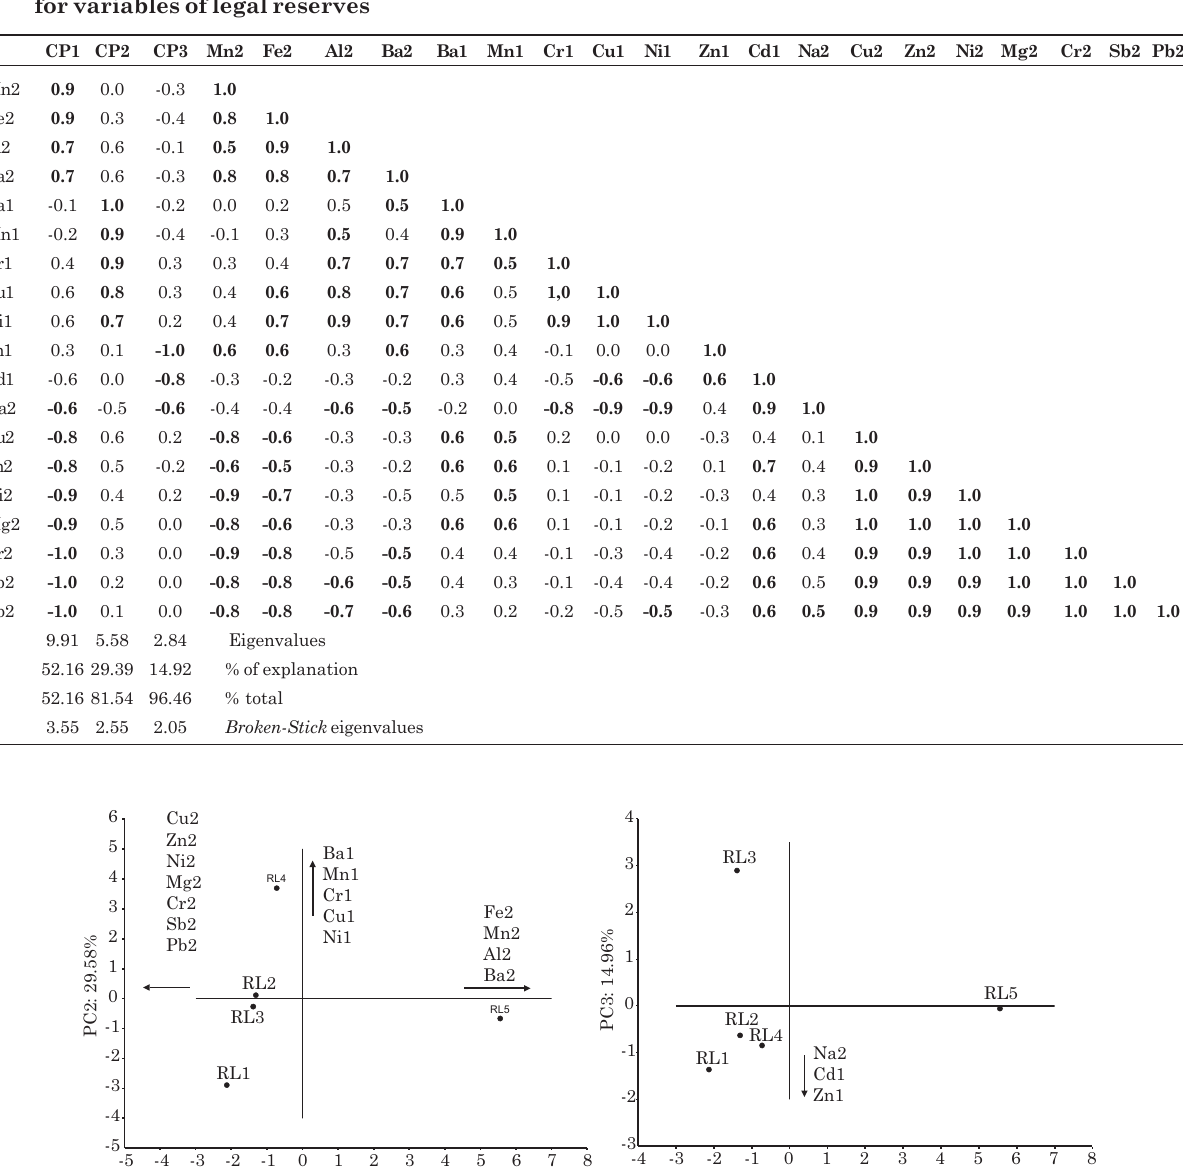
Table 4. Values of correlation, eigenvalues, percentage of explanation and “Broken Stick” retention coefficient for variables of legal reserves